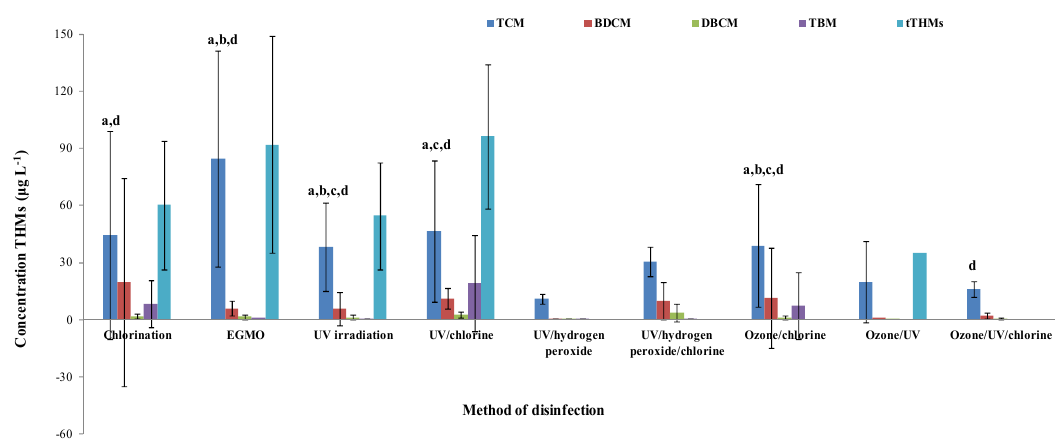
Figure 1. Mean and standard deviation of THMs with different methods of disinfection. Note: “ a ” shows that chlorination, EGMO, UV irradiation, UV/chlorine and ozone/chlorine are not significantly different from each other; “ b ” shows that EGMO is significantly different from UV irradiation and ozone/chlorine; “ c ” shows that UV irradiation, UV/chlorine and ozone/chlorine are not significantly different from each other; “ d ” shows that ozone/UV/chlorine is significantly different from chlorination, EGMO, UV irradiation, UV/chlorine and ozone/chlorine at α = 0.05 ( p < 0.05); Statistical analysis to compare the means in case of UV/hydrogen peroxide, UV/hydrogen peroxide/chlorine and ozone/UV was not carried out because of fewer data points.